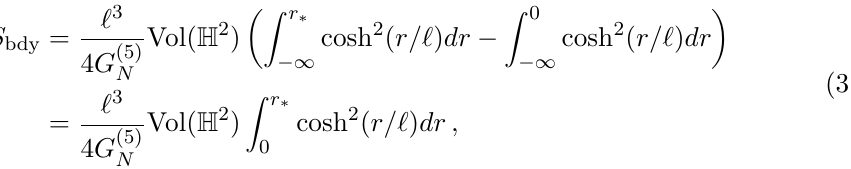
Figure 13 . The colored region is the RT surface of S BCFT . The RT of 1 orange region at the right side of dashed